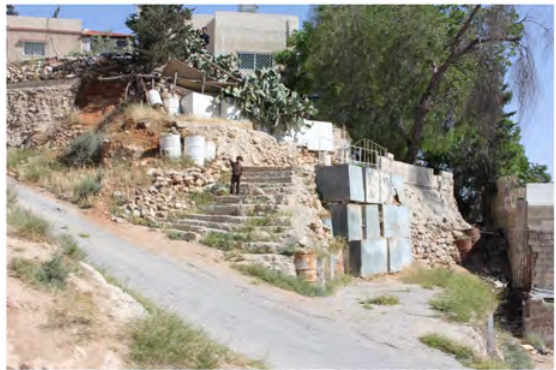
Figure 5. Examples of Fadlih ’s, Nutfih’s and Arasah ’s 1. Source: Author (2015)